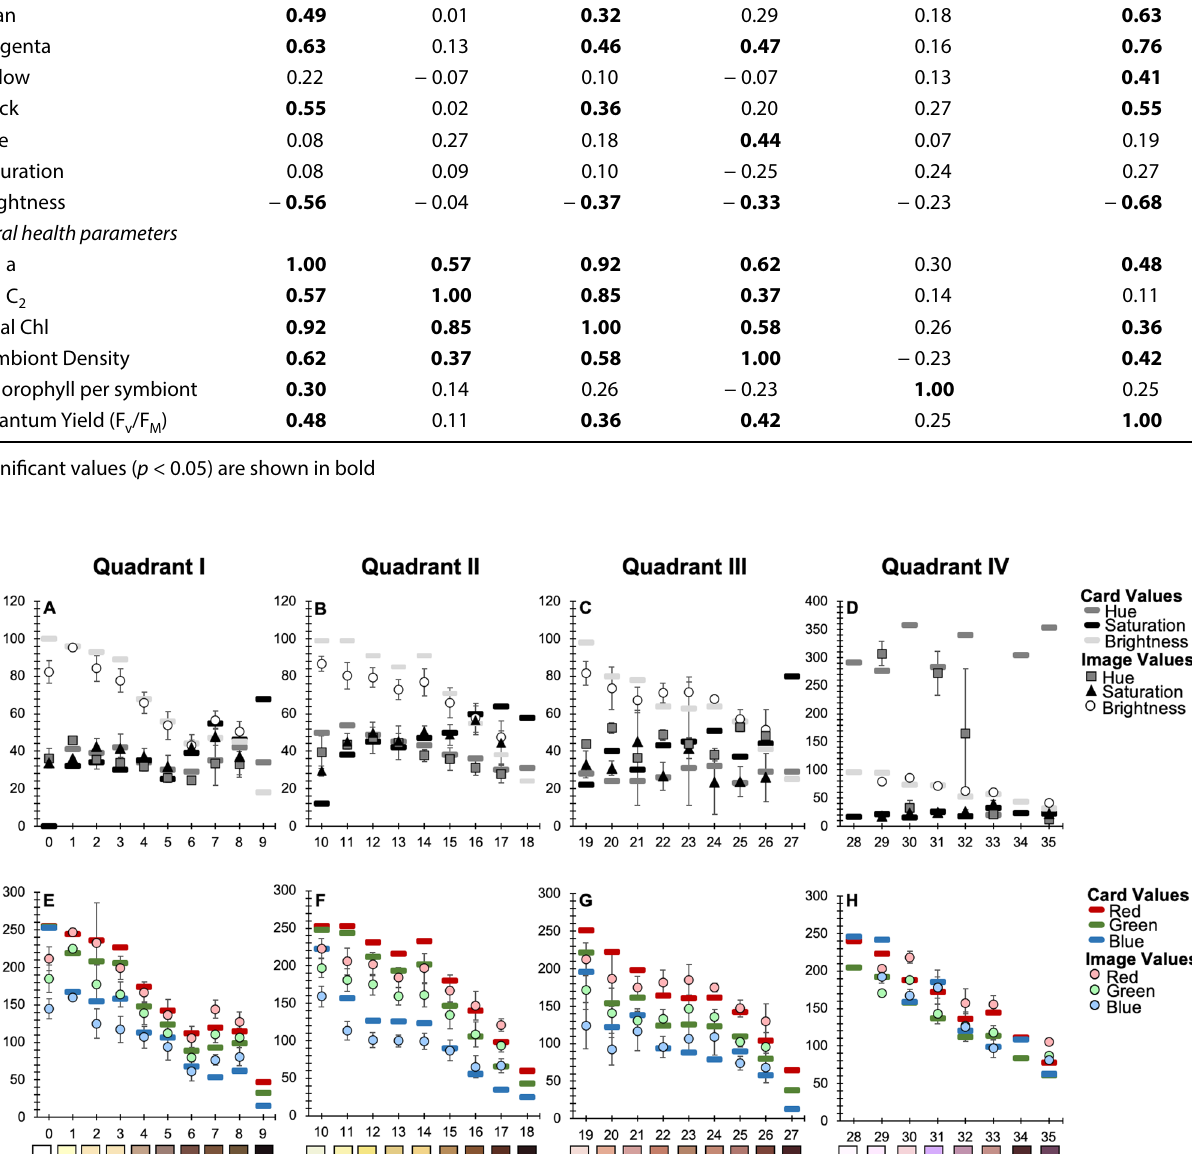
Fig. 6 Color scale of hue, saturation, and brightness (HSB) ( A – D ) and red, blue, and green (RGB) values ( E – H ) for the Hawaiian Ko ʻ a Card numbers (0–35). Color scale values of the Hawaiian Ko ʻ a Card are indicated by bold bars. Mean color scale values from the images of the corals are indicated by markers for HSB scale (hue,